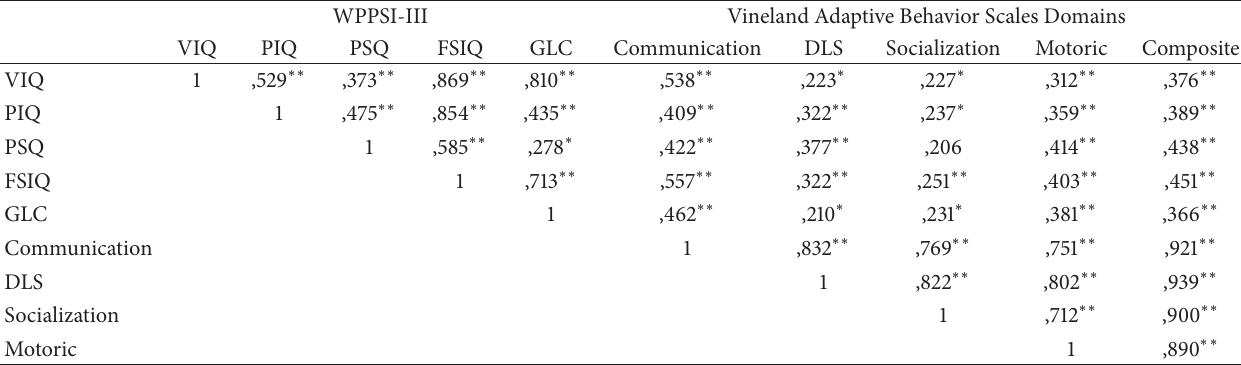
Table 2: Pearson correlations between WPPSI-III index scores and Vineland Adaptive Behavior Scales Domains. WPPSI-III Vineland Adaptive Behavior Scales Domains Communication DLS Socialization Motoric